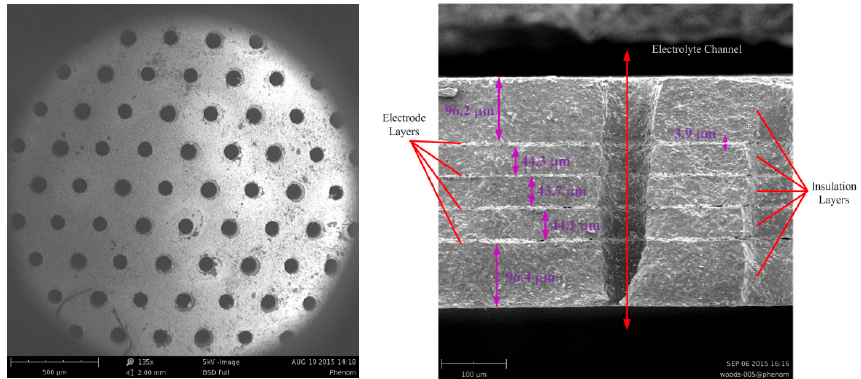
Figure 2. Sensing element with microflow channels ( left ) and dimensions of the intersection of the surface of a single channel ( right ).